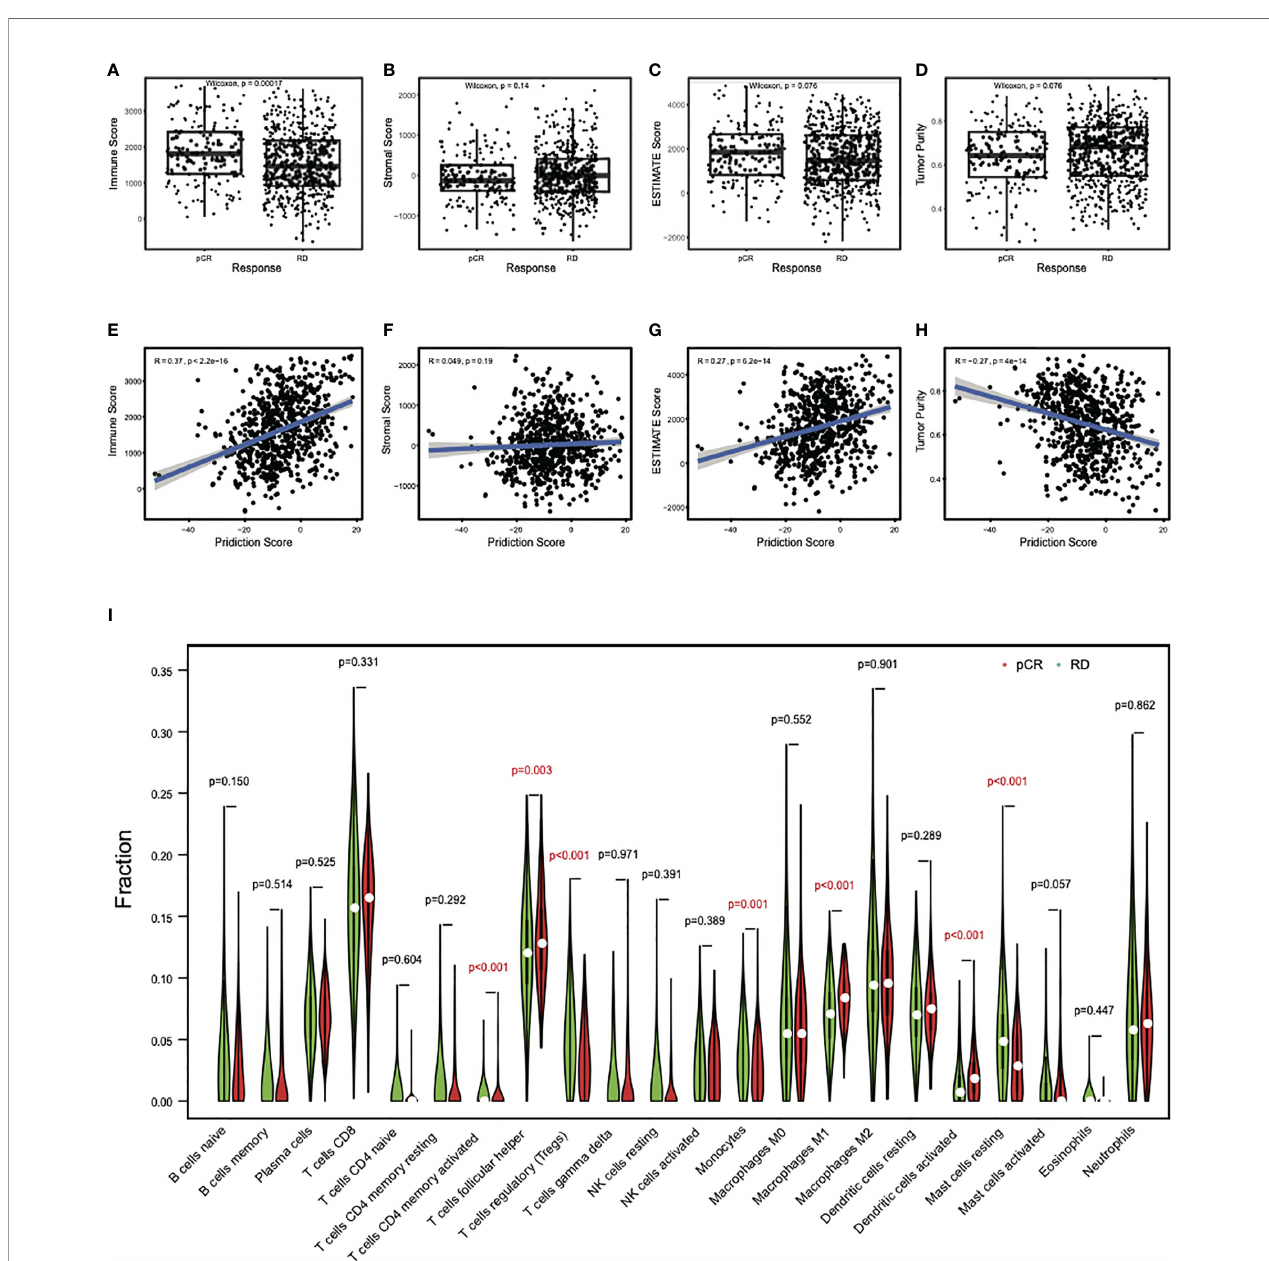
FIGURE 5 | Differential immune cell abundances between pCR and RD samples. (A) The mean immune score in pCR samples was signi fi cantly higher than that in RD samples. (B) The mean stromal score showed no difference between pCR and RD samples. Compared to RD samples, (C) the mean ESTIMATE score was higher in pCR samples, but (D) tumor purity decreased. Prediction scores were positively correlated with (E) immune scores and (G) ESTIMATE scores, but not with (F) stromal scores. (H) There was a signi fi cant negative correlation between prediction score and tumor purity. (I) Immune cell types showed signi fi cant difference between pCR and RD samples. The fractions of “ T cells CD4 memory activated, ” “ T cells follicular helper, ” “ Macrophages M1, ” and “ Dendritic cells activated ” were signi fi cantly higher in pCR than RD samples, whereas the fractions of “ T cells regulatory, ” “ Monocytes, ” and “ Mast cells resting ” were signi fi cantly lower in pCR than RD samples. pCR, pathologic complete response; RD, residual